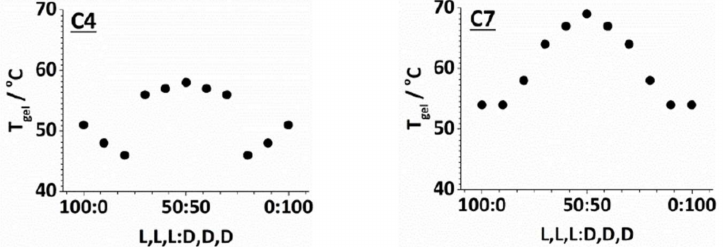
Figure 2. Typical examples of the effect of enantiomeric mixing on T gel , as measured by tube inversion. The concentration of amine in toluene is 10 mM, and the total concentration of dendron (D,D,D + L,L,L) is also 10 mM. The amines for which data are represented are C4 ( left ) and C7 ( right ). Data for all amines can be found in the Supplementary